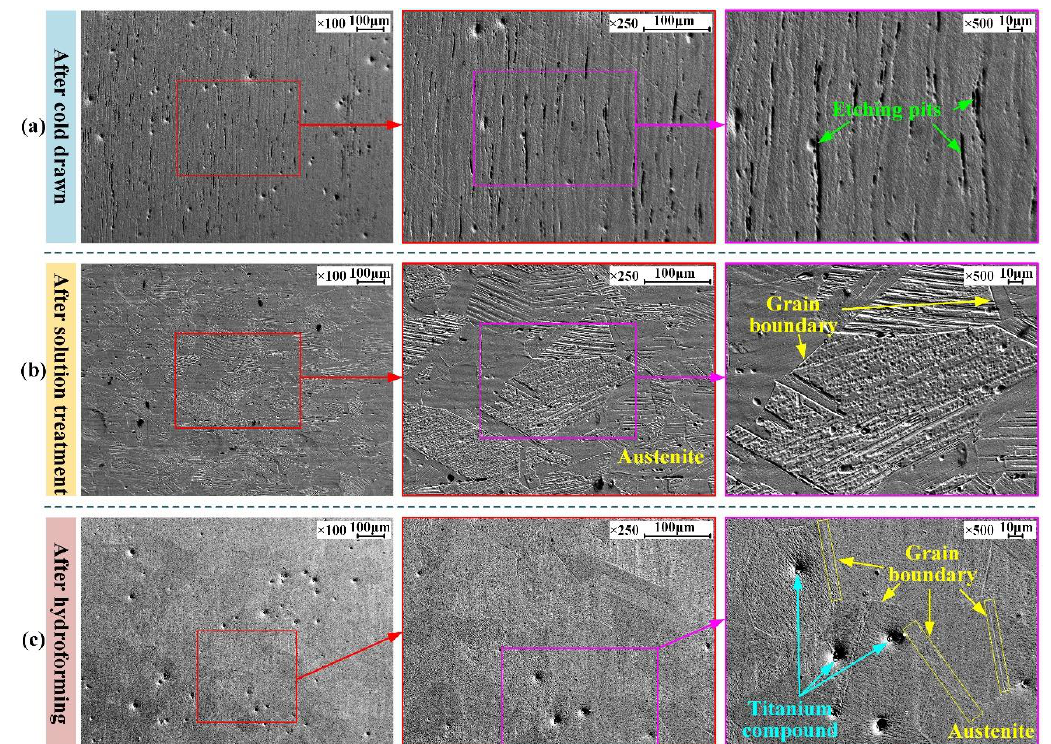
Figure 17. SEM images of patch tubes after different processes.